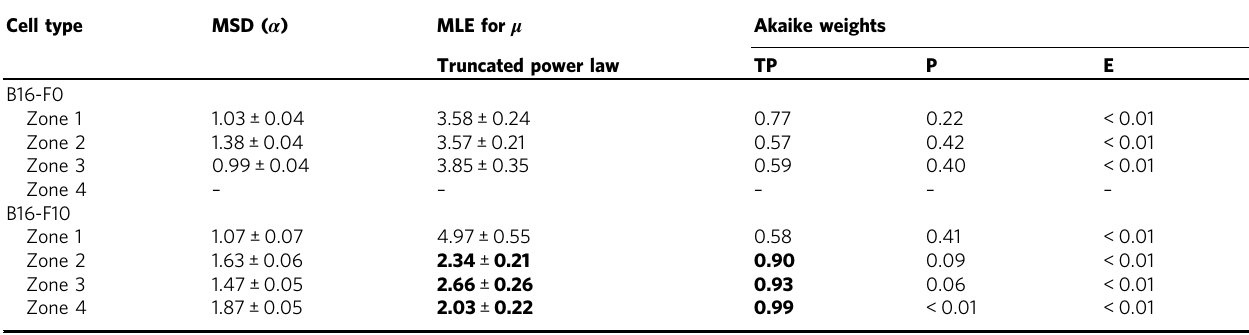
Table 2 Statistical analysis of cancer cell movements in vivo Cell